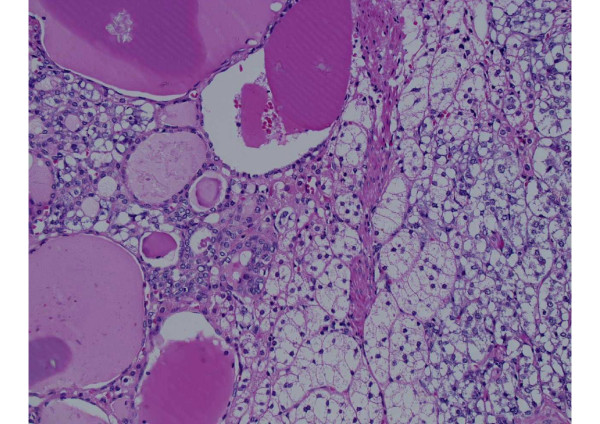
Photomicrograph of thyroid tissue in the adrenal gland. H&E section shows that the follicle contained eosinophilic colloid-like material lined by a single-layered epithelium (arrow) (×400).